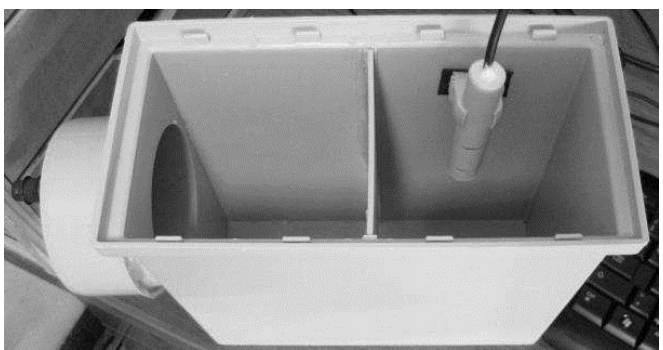
Figure 12. Test box used for in lab prototype testing.